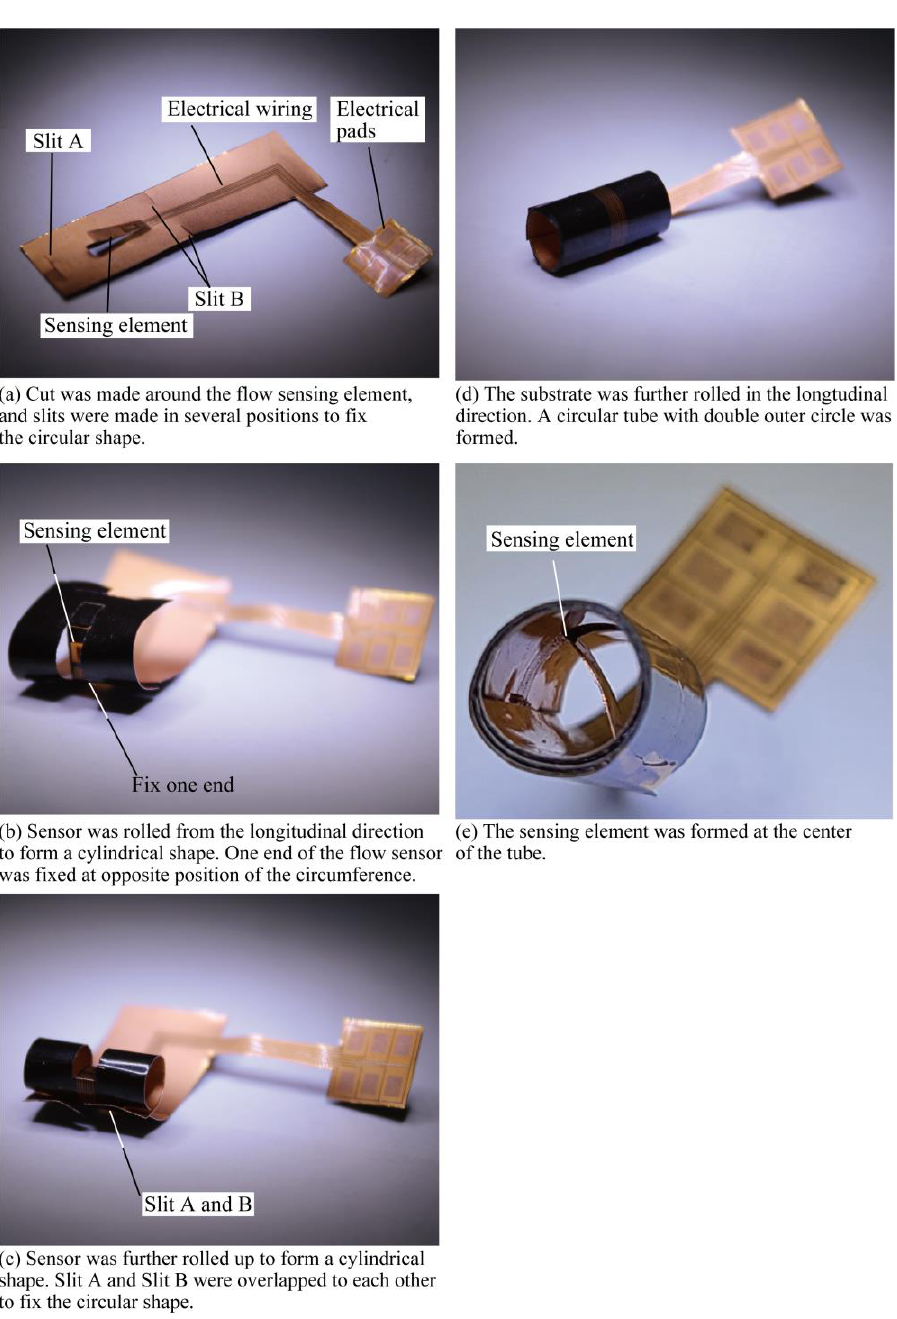
Figure 8. Procedure for deforming the sensor fabricated on the COP substrate into a circular tube shape.